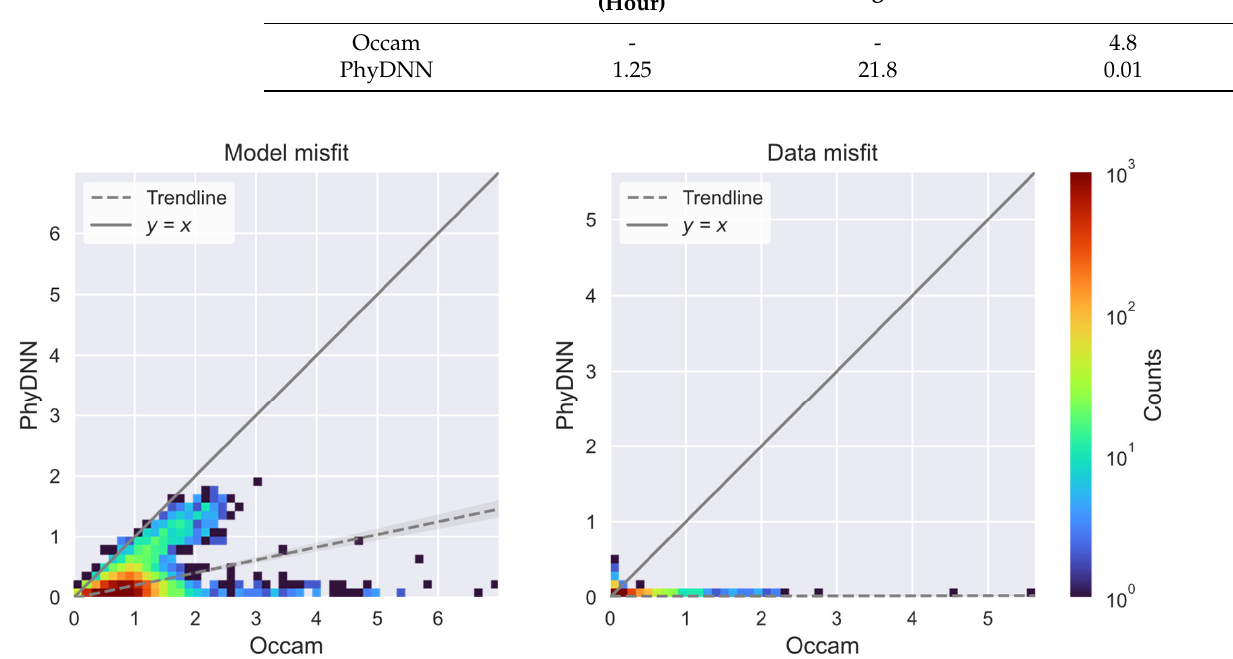
Figure 9. The model and data misfit scatter density plots between the Occam and PhyDNN for the test set. Table 3. Mean model and data misfits of the test set for Occam and PhyDNN.